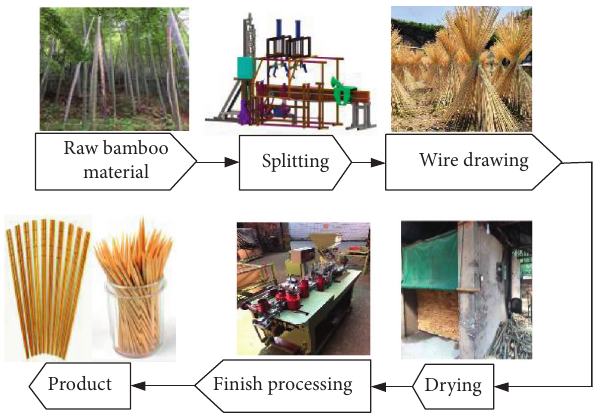
Figure 1: The production process for bamboo